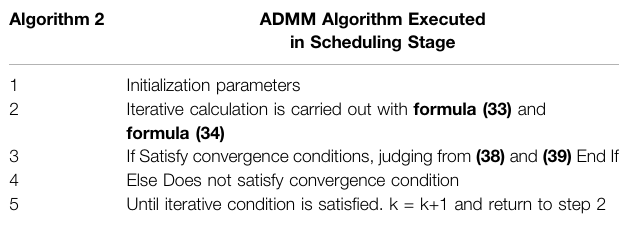
TABLE 2 | Solution fl ow of ADMM algorithm in optimal scheduling stage. Algorithm 2 ADMM Algorithm Executed in Scheduling Stage